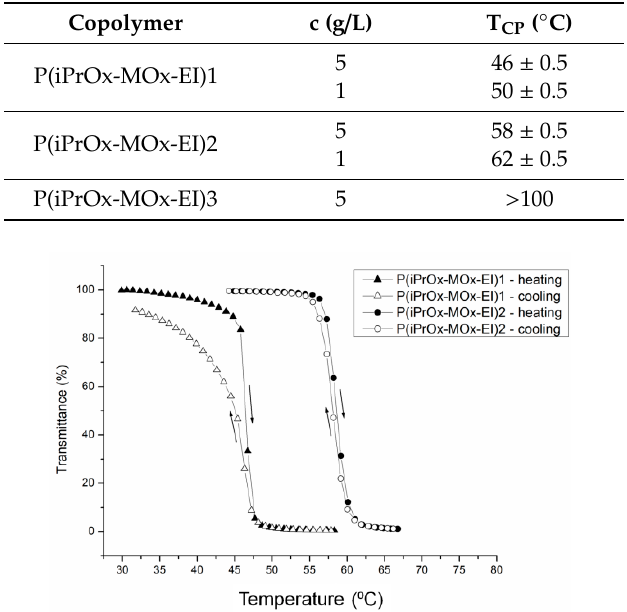
Table 5. T CP values of aqueous solutions of copolymers after hydrolysis at di ff erent concentrations.